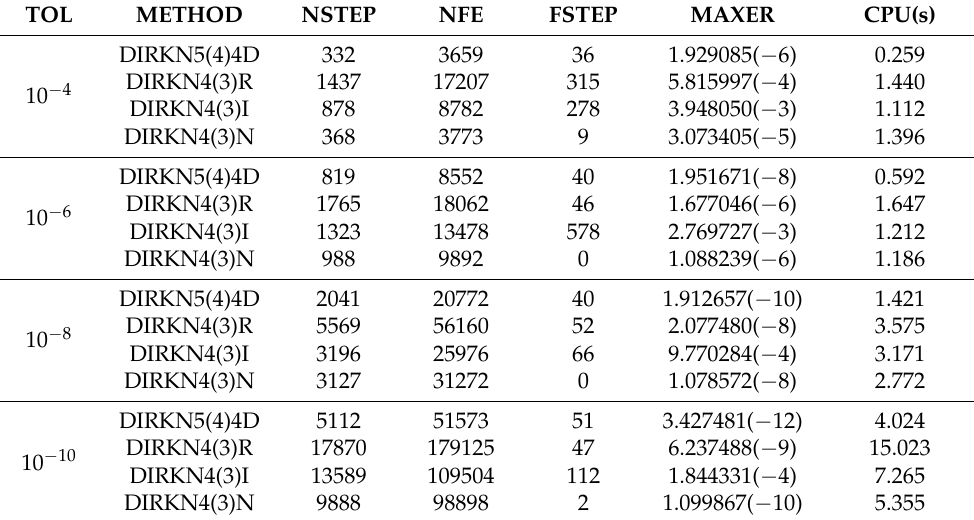
Table 7. Data for Example 6.